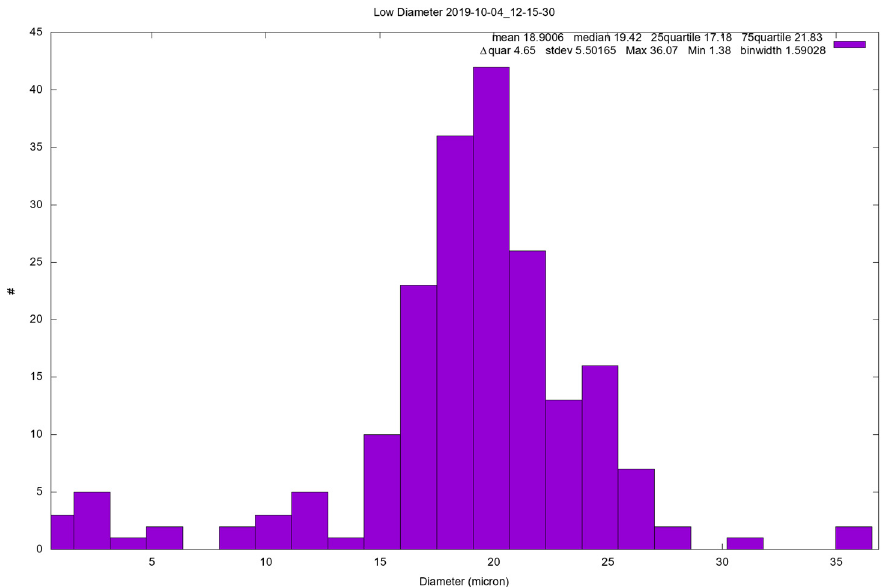
Figure 8. Example of test performed at the Capodimonte laboratory injecting 19.7-µm calibrated SiO 2 particles .